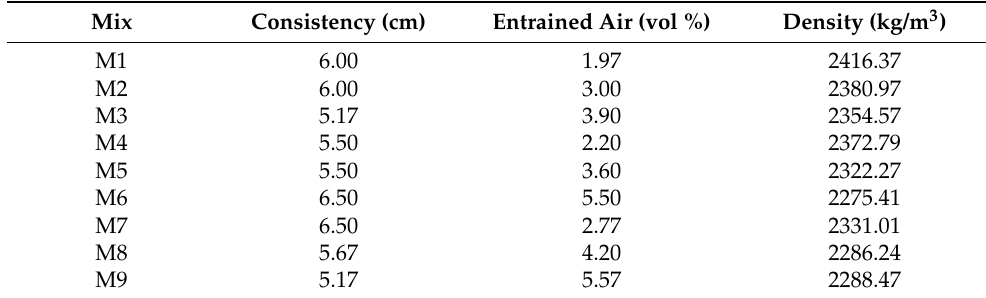
Table 6. Concrete properties in a fresh state.